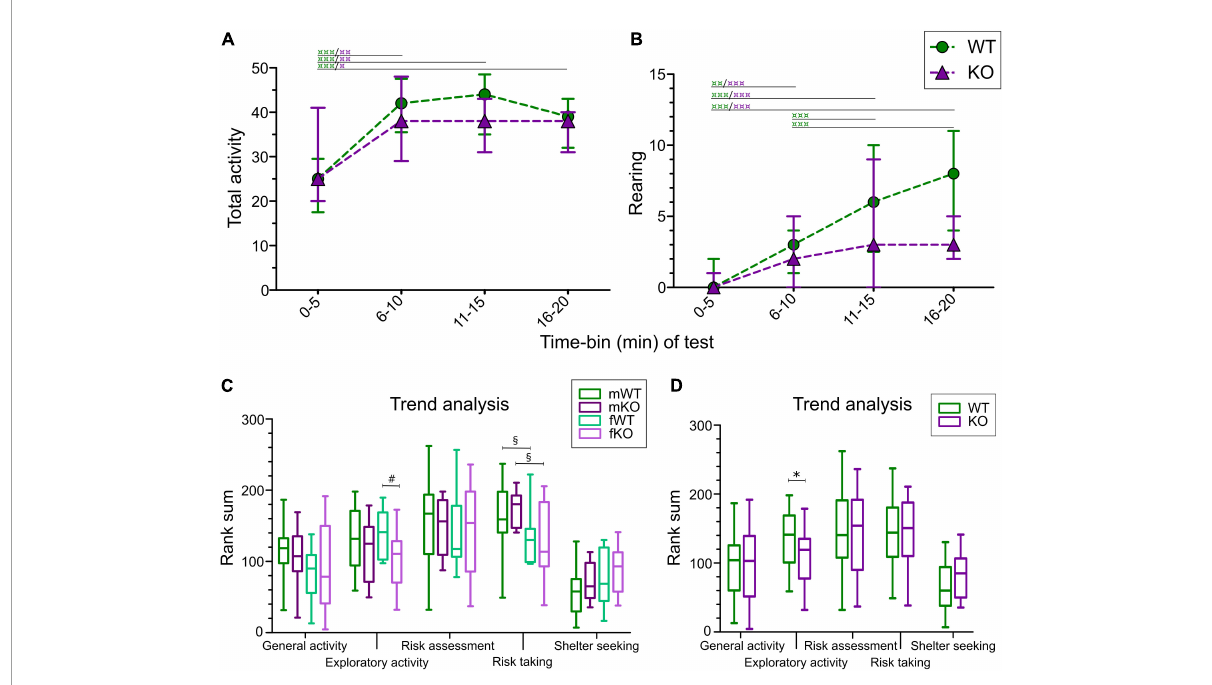
FIGURE2 Activity and trend analysis of MCSF data in SLC38A10 KO and WT mice. (A) Total activity (Tot Act; sum of all frequencies) and (B) number of rearings of WT and KO mice divided into 5-min time-bins. Analysis was made with the nparLD-package in R, with post hoc Wilcoxon matched pairs test. p < 0.05, p < 0.01,